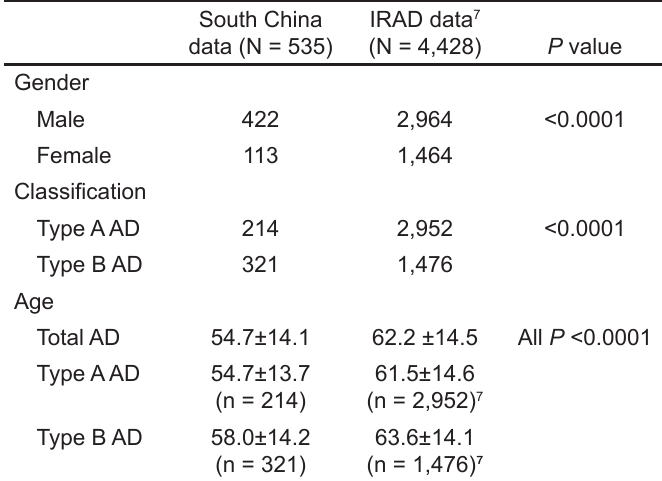
Table 1. Gender, classification and age differences between South China and Western populations (IRAD* data).